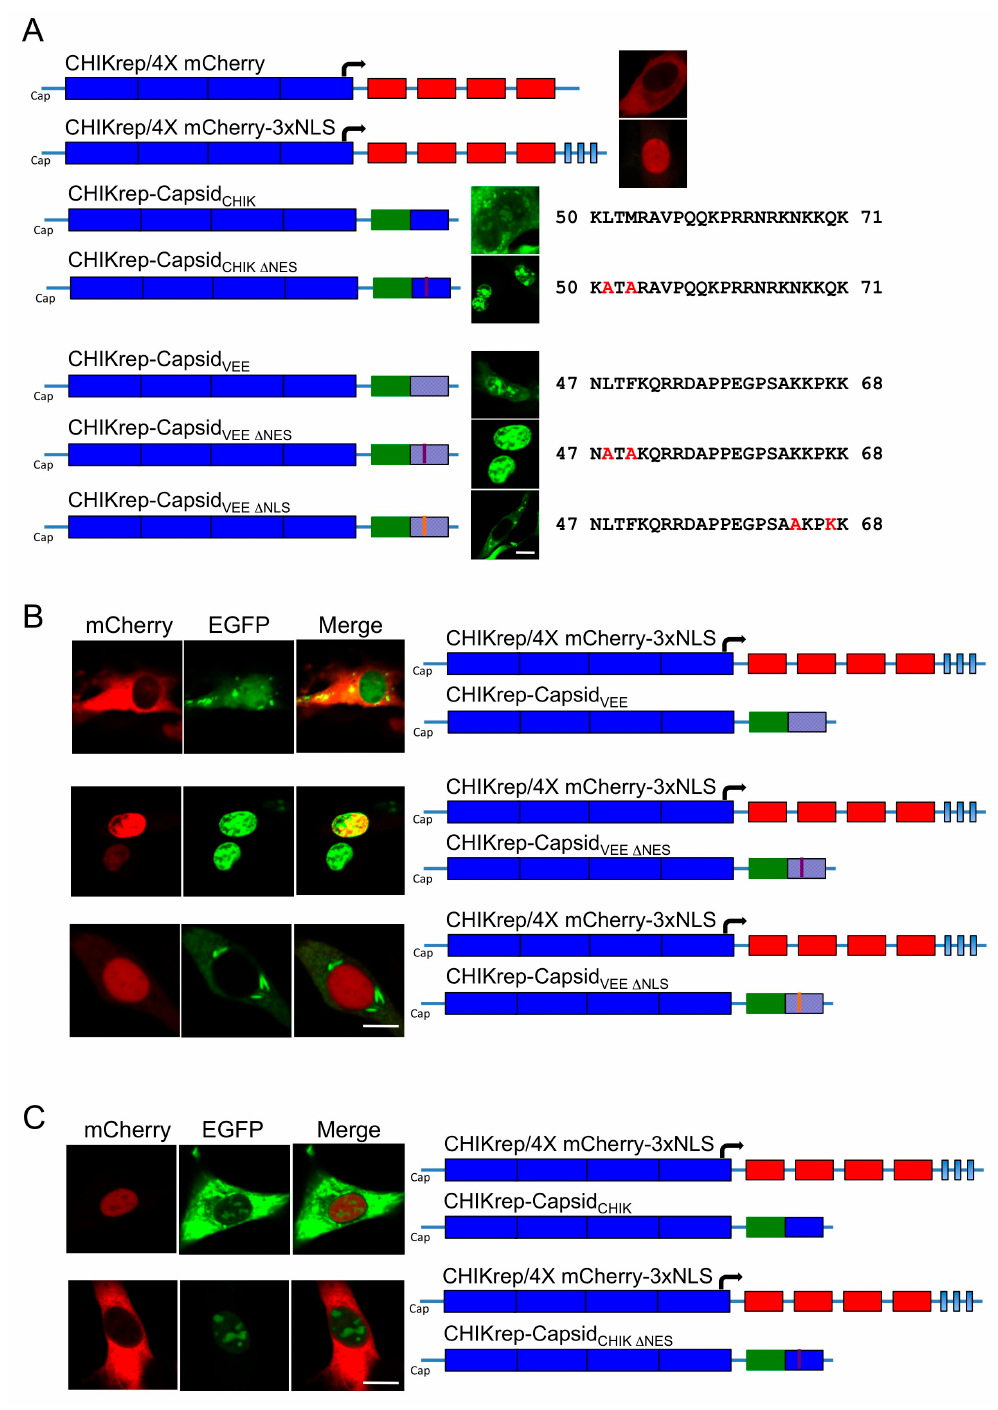
Figure 2. Functional CHIKV capsid protein NES is required for nuclear import. ( A ) BHK-21 cells were electroporated with CHIKV replicons (solid blue) encoding four mCherry proteins (CHIKrep/4X mCherry) (solid red) or four mCherry proteins plus three copies of the SV40 nuclear localization signal (CHIKrep/4X mCherry-3xNLS) (solid light blue) under control of subgenomic promoter, together with either; ( B ) EGFP-VEEV capsid (hatched blue), EGFP-VEEV ∆ NES capsid (mauve bar) or EGFP-VEEV ∆ NLS capsid (orange bar), or ( C ) EGFP-CHIKV capsid, EGFP-CHIKV ∆ NES capsid. Cells were fixed after 24 h and EGFP and mCherry fluorescence analyzed by direct visualization. Images are representative of three independent experiments and at least six fields of view. The white bars represent 15 µm.